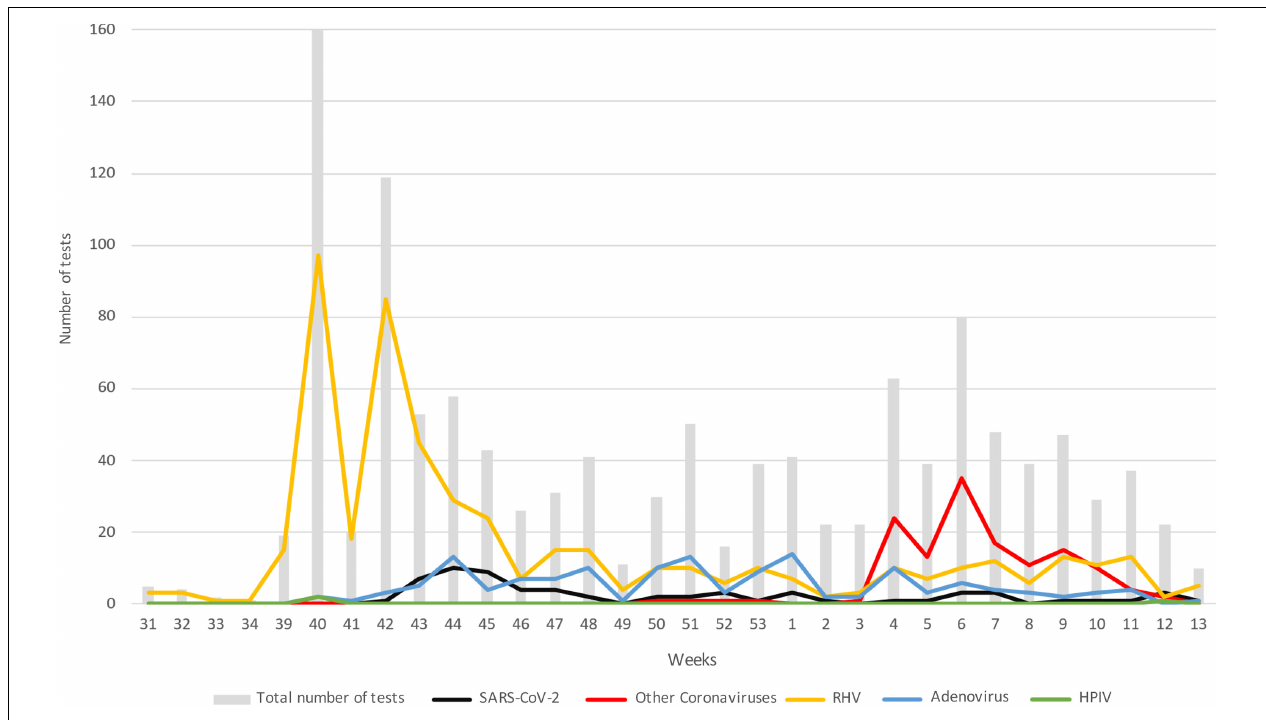
FIGURE 1 | Trend in the number of the main pathogens detected over time; data are represented as the number of positive subjects for each of the viruses considered: gray bar, total number of test; black, SARS-CoV-2; red, other coronaviruses; yellow, HRV; blue, adenovirus; green, HPIV. Data are represented starting from August 1, 2020 (week 31) until March 31, 2021 (week 13). HRV, human rhinovirus; HPIV, human parainfluenza virus.